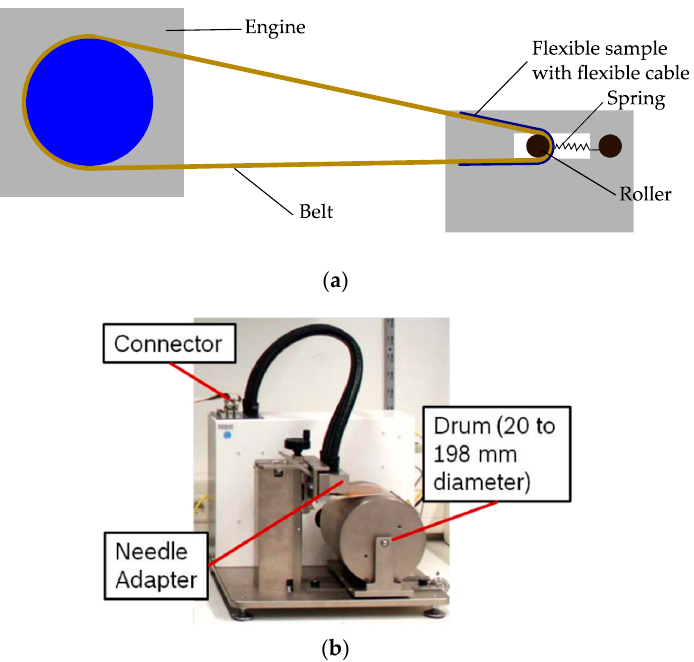
Figure 19. Examples of two bending test setups using the roll to flex bending measurement method with decoupled influence of tensile forces on the bent samples; ( a ) on-belt flex bending setups (modified and freely sketched after [6]) and ( b ) bending test device (reproduced with permission)